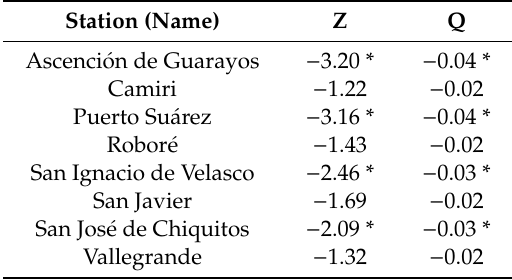
Table 3. Spatial analyses of drought trends SPEI-12 (1980–2019) for weather stations in the Department of Santa Cruz, in relation to the Mann-Kendall test (Z) and Sen’s estimator (Q). Station (Name) Z Q Ascenci ó n de Guarayos − 3.20 * − 0.04 * Camiri − 1.22 − 0.02 Puerto Su á rez − 3.16 * − 0.04 * Robor é − 1.43 − 0.02 San Ignacio de Velasco − 2.46 * − 0.03 * San Javier − 1.69 − 0.02 San Jos é de Chiquitos − 2.09 * − 0.03 * Vallegrande − 1.32 − 0.02 Values with an asterisk (*) indicate significance at the confidence level ( p <